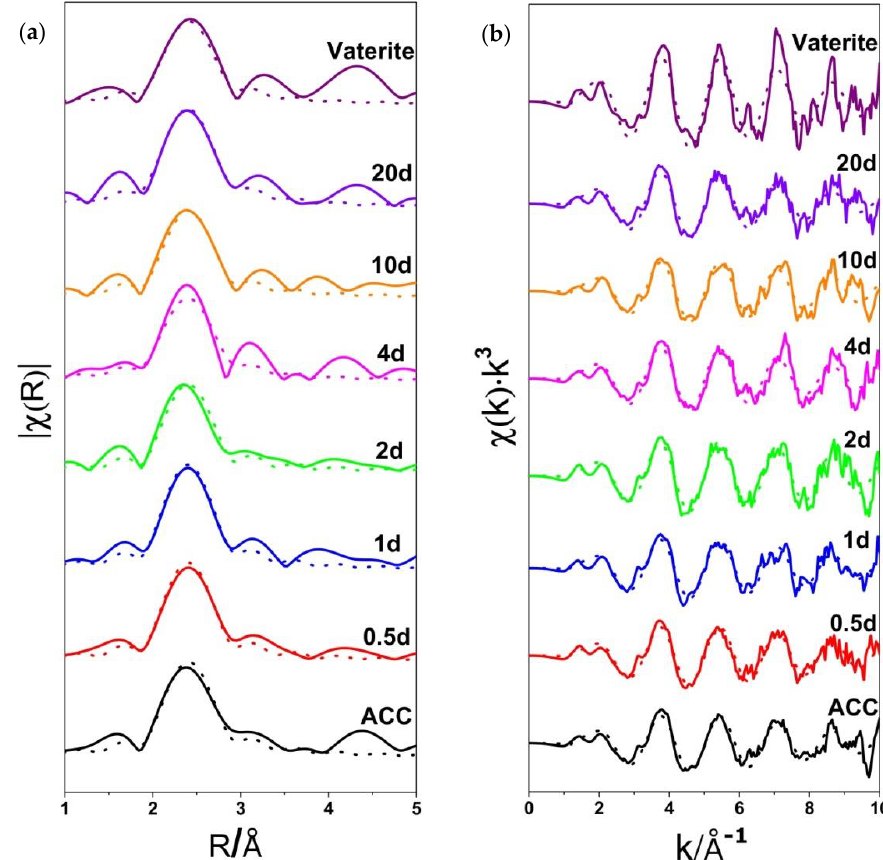
Figure 3. Ca K-edge extended X-ray absorption fine structure (EXAFS) spectra for the first coordination shell of the experimental data (solid line) and the fitting results (dotted line) for proto-vaterite ACC, samples crystallized for different times and well-crystalline vaterite reference plotted in R space (Fourier transform magnitude) ( a ) and k space ( b ).